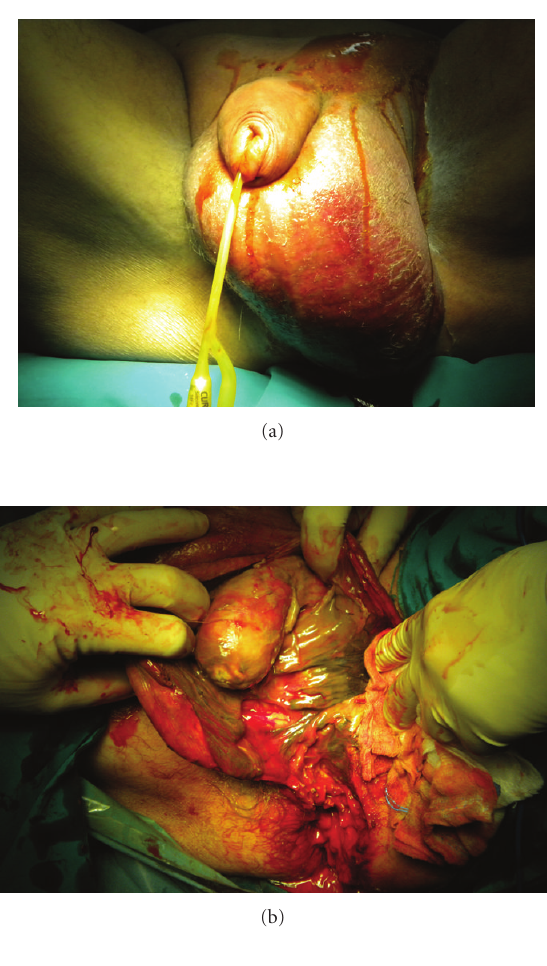
Figure 2: (a) Preoperative image showing considerable edema and scrotal necrosis. (b) Intraoperative image of the immediate surgical debridement demonstrating the extensive necrosis of the scrotum and perianal region.